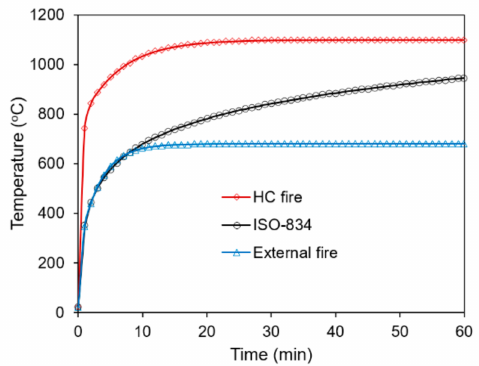
Figure 11. Various fire